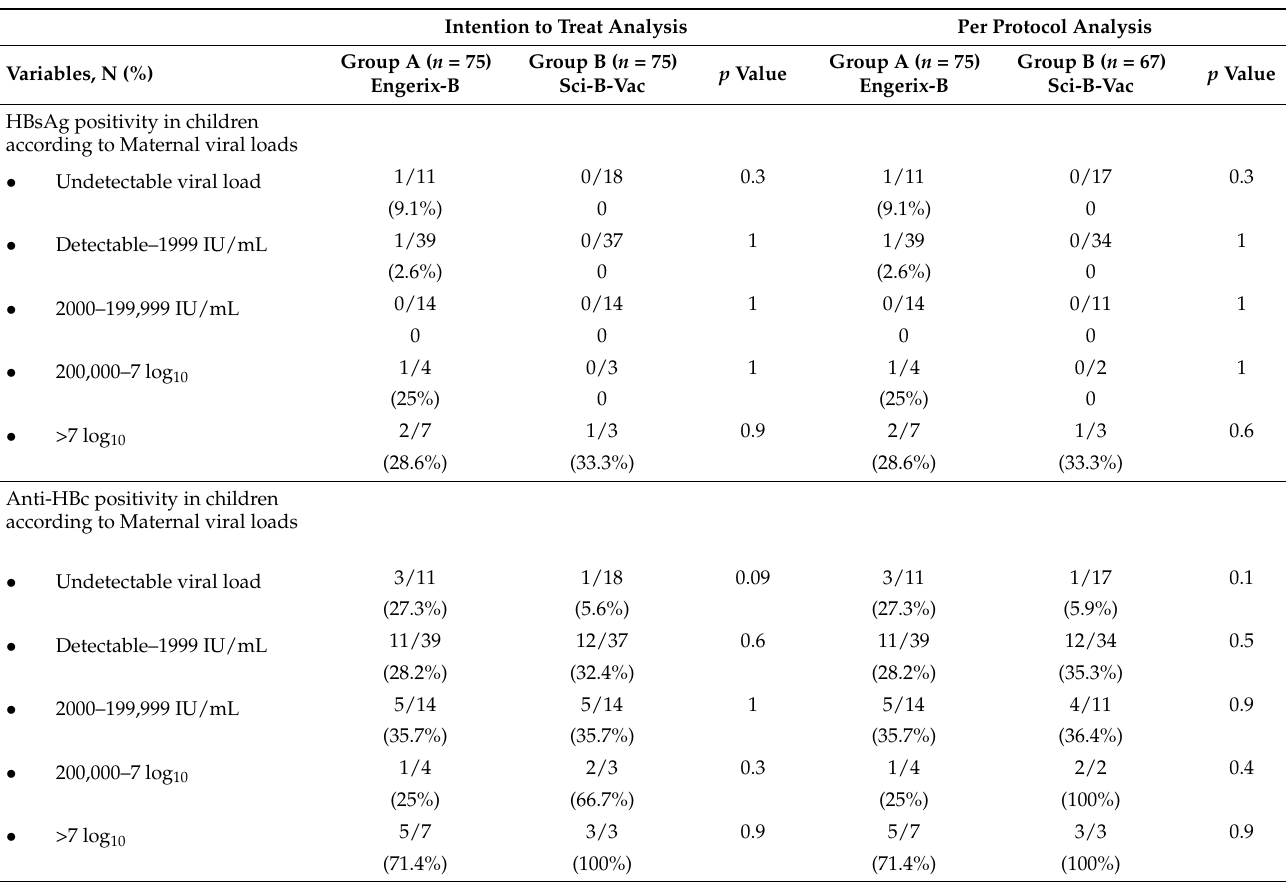
Table 4. Fetal HBsAg and anti-HBc status among mothers who were not treated by antivirals during pregnancy. Intention to Treat Analysis Per Protocol Analysis